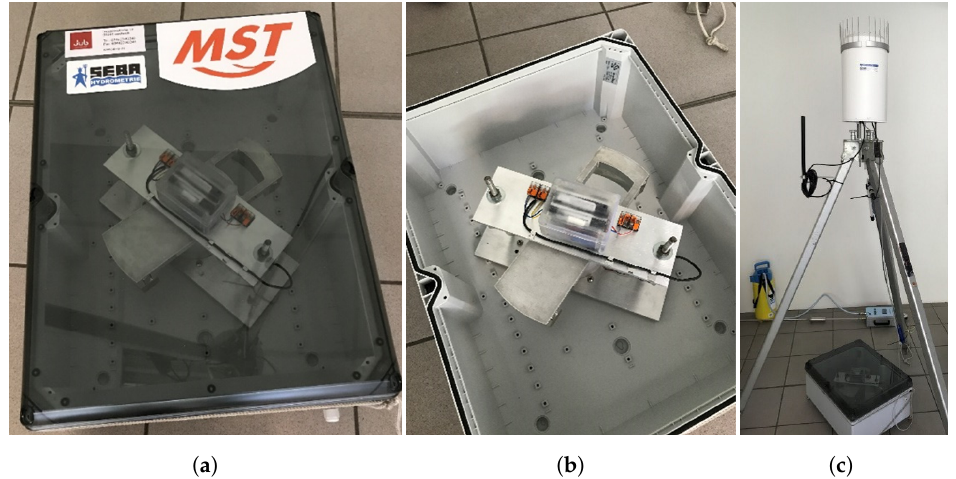
Figure 13. ( a ) Housing of the final pendulum converter system, ( b ) pendulum based converter and energy management and storage circuits integrated in the housing, ( c ) components of the final prototype with precipitation sensor, electronic platform, and temperature